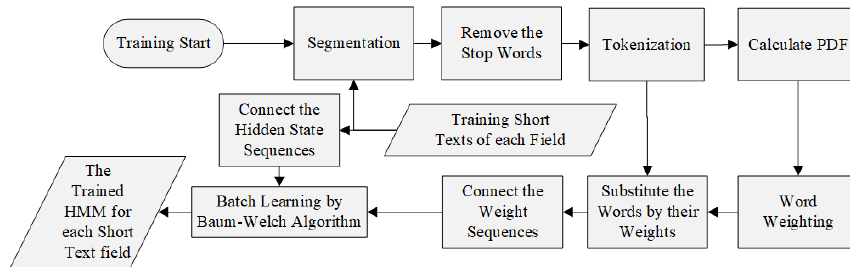
Figure 1. HMM training.